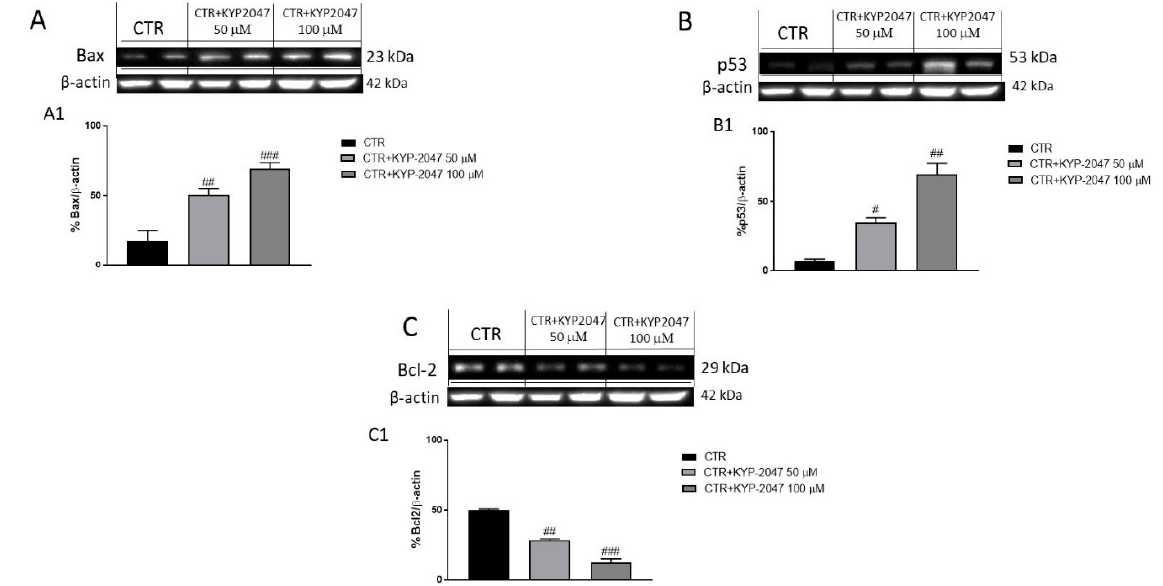
Figure 8. Effect of KYP-2047 on apoptosis pathway in U-87 cell lysates. The blots on U87 cell lysates revealed an increase of pro-apoptotic Bax and p53 expression following KYP-2047 treatment at the concentrations of 50 µM and 100 µM compared to control group ( A , B ). Moreover, KYP-2047 at the concentrations of 50 µM and 100 µM reduced significantly Bcl2 expression compared to control group ( C ). Data are representative of at least three independent experiments. ( A ) ## p < 0.01 vs. CTR; ### p < 0.001 vs. CTR; ( B ) # p < 0.05 vs. CTR; ## p < 0.01 vs. CTR; ( C ) ## p < 0.01 vs. CTR; ### p < 0.001 vs. CTR.